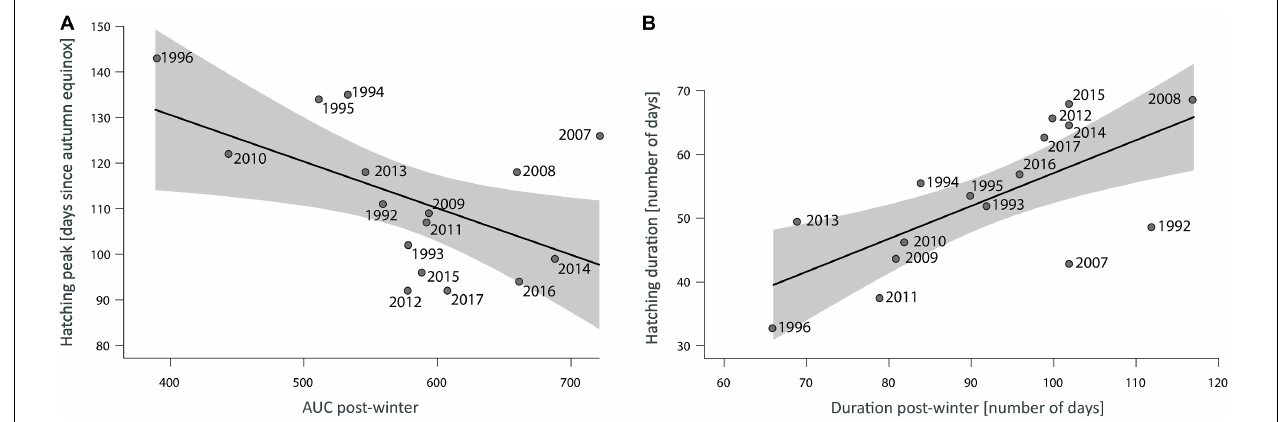
FIGURE 5 | Predicted linear relationships (lines) and associated 95% CI (shadows) by the best candidate models on hatching responses. (A) Effect of AUC in the period after the increasing temperature curve crossed the initial spawning threshold range (post-winter) in the period from the autumn (9/22) equinox to the first solstice (6/21) when the major abundance of hatchlings (yolk-sac larvae) occurred. (B) Effect of the post-winter duration on the duration of the hatching period in days. Points represent the yearly estimates of the variables related to empirical value of the post-winter descriptors.